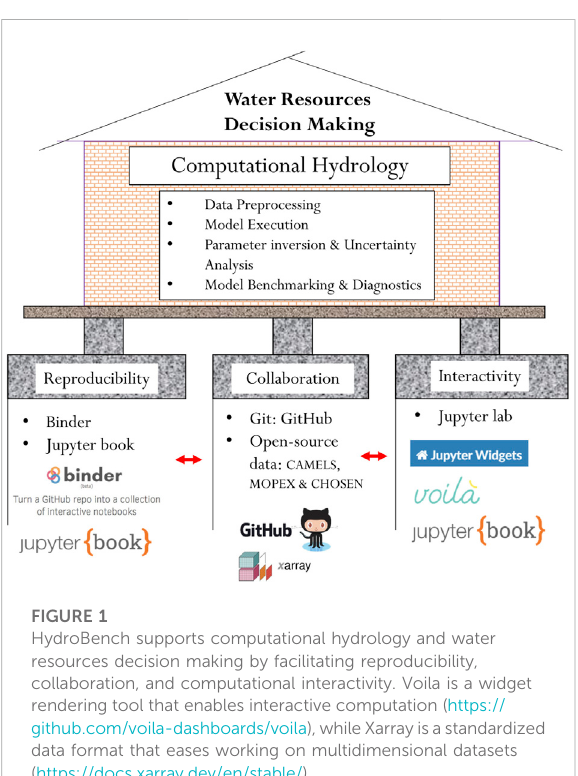
FIGURE 1 HydroBench supports computational hydrology and